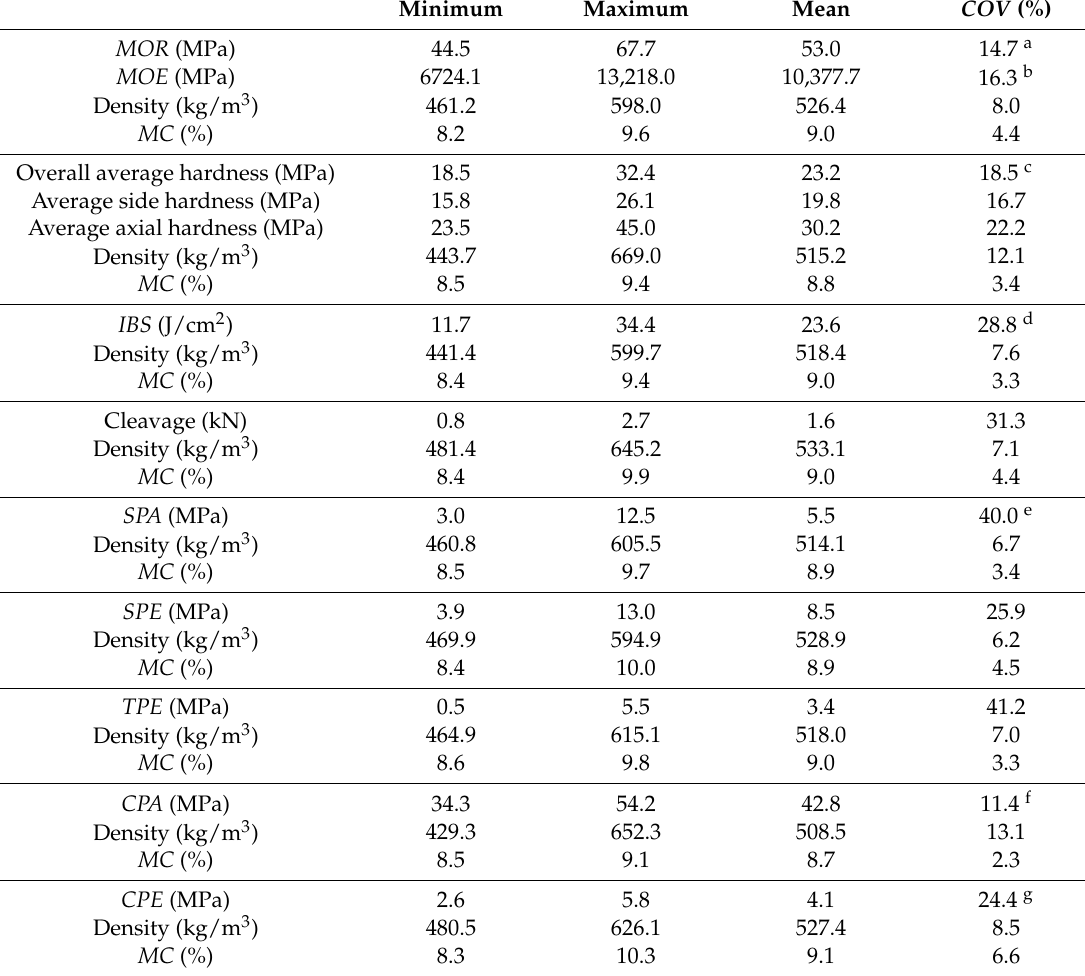
Table 3. The mechanical properties of the plantation E. nitens .